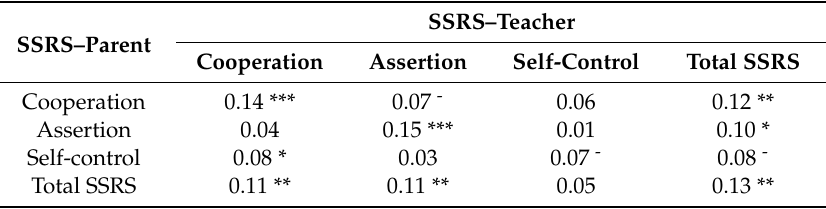
Table 4. Correlation coe ffi cients of the parents’ and the teachers’ ratings (n =